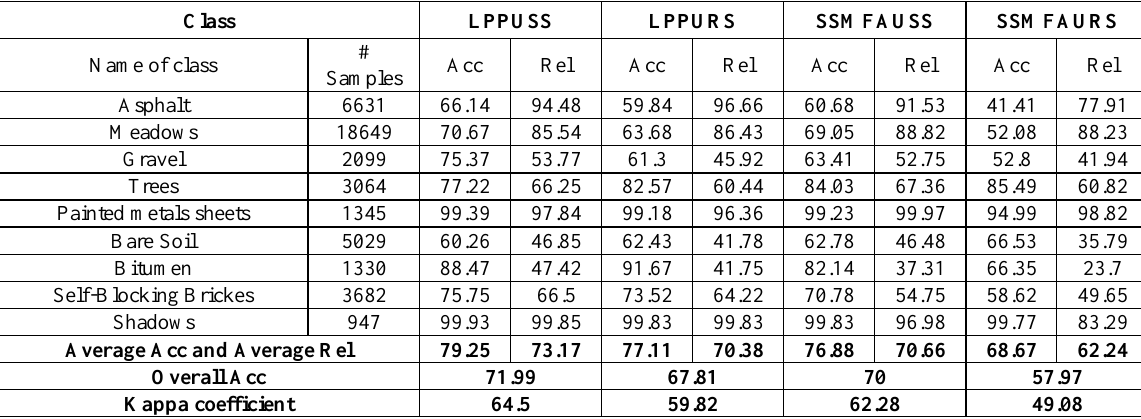
Table 1. Classification results for PU dataset obtained by SVM classifier, 10 training samples, 1400 unlabeled samples